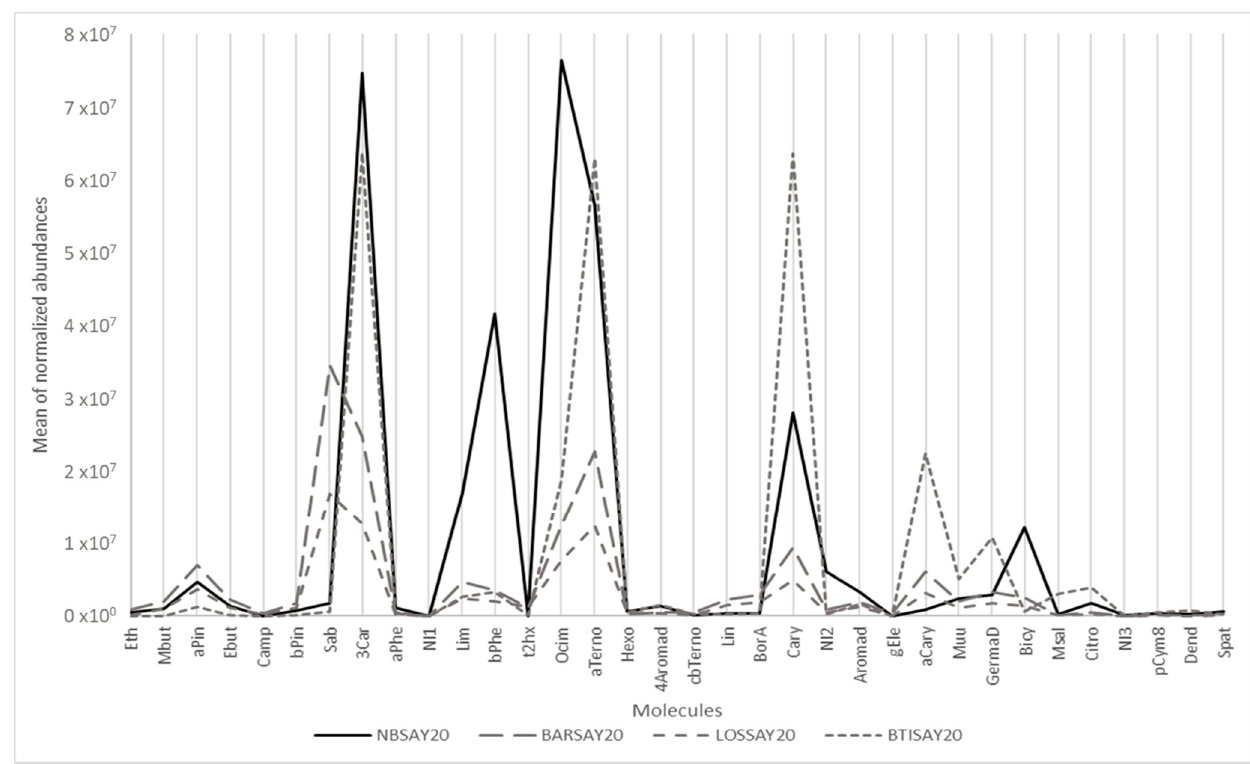
Figure 1. Graphical representation of the main odorant volatiles extracted from berries of different cultivars.